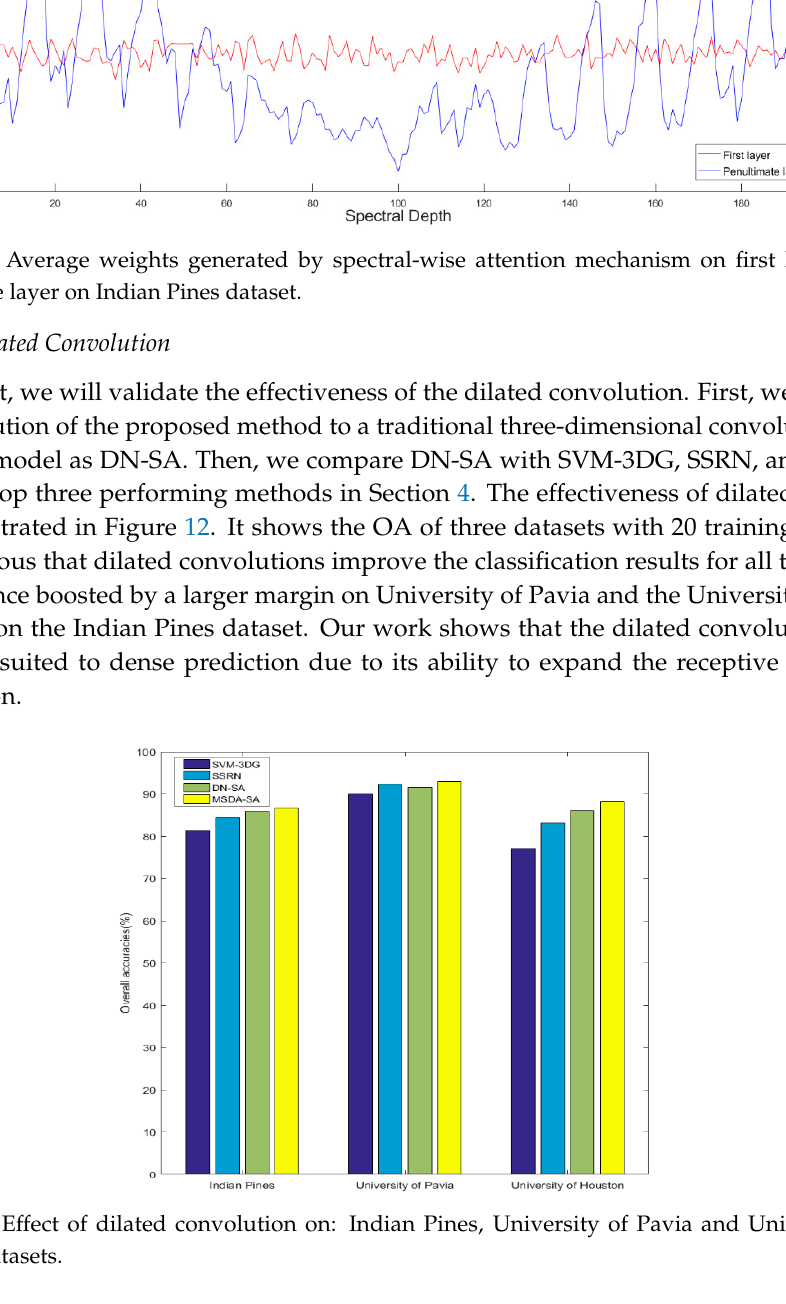
Figure 10. Effect of spectral-wise attention on: Indian Pines, University of Pavia and University of Houston datasets .